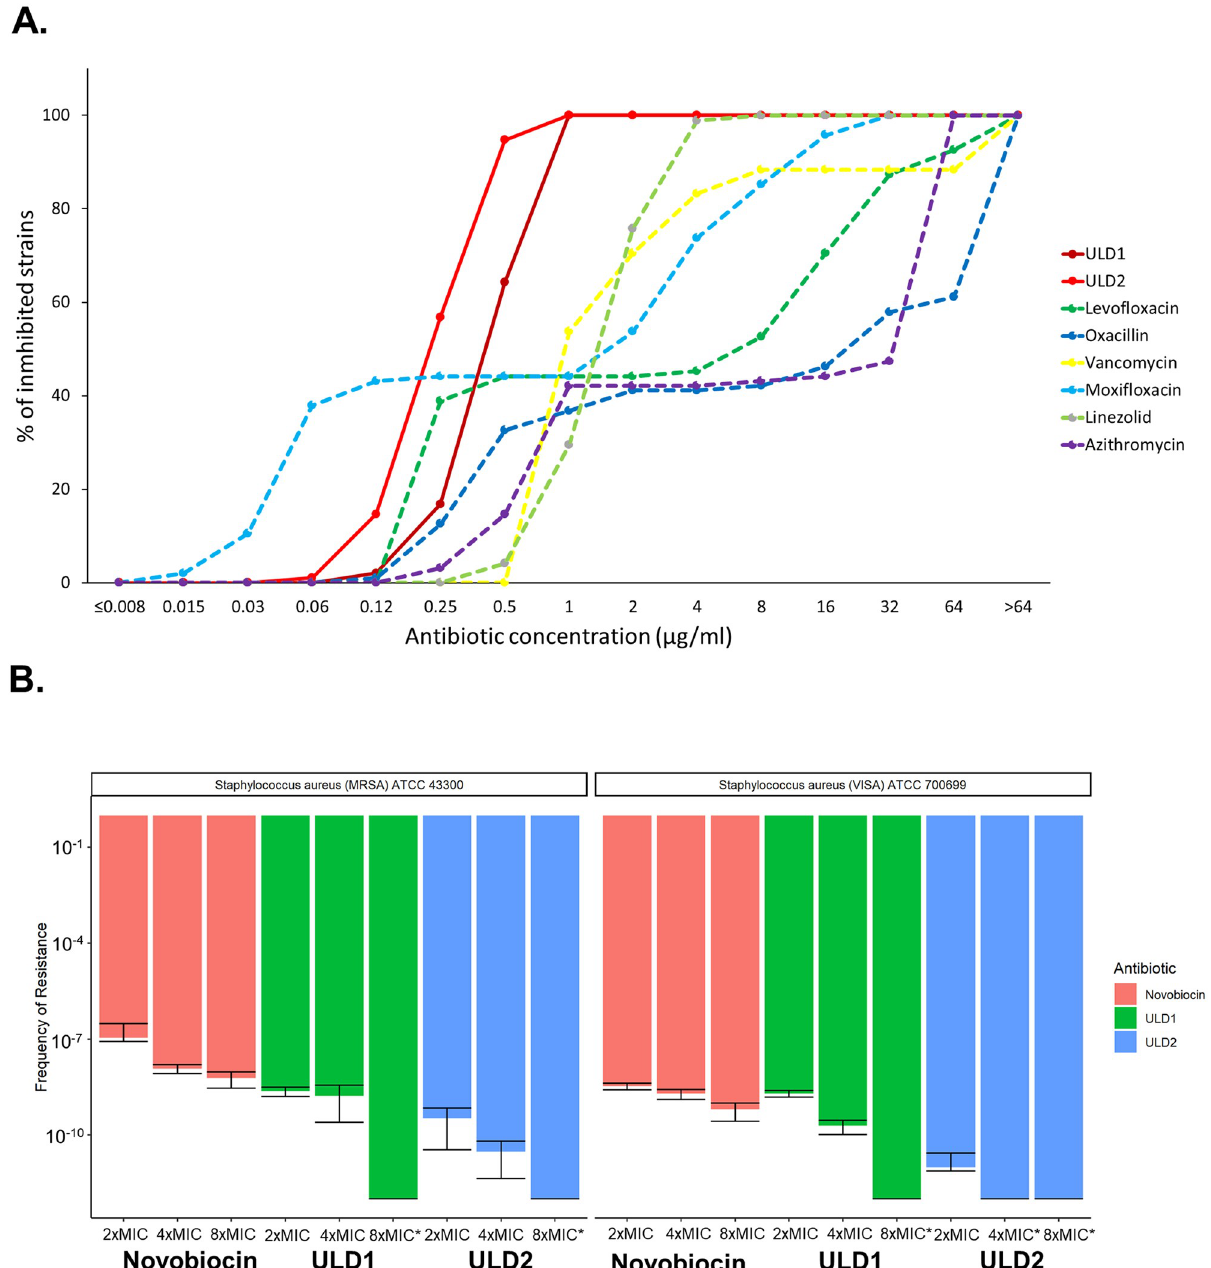
Fig 2. Antibacterial activities and spontaneous frequency-of-resistance of ULD1 and ULD2. A. Antibacterial activities of ULD1 and ULD2 against a panel of 95 S . aureus clinical isolates. Strains included 55 MRSA and 28 vancomycin-intermediate or -resistant isolates with diverse geographic origins (see S1 Data Table 1 for the strains’ description). All strains (100%) were inhibited at 1 μ g/mL concentration of ULD1 and ULD2. MICs were determined via broth microdilution according to CLSI guidelines. The underlying data for this figure can be found in S2 Data. B. Spontaneous frequency-of-resistance of ULD1, ULD2, and novobiocin in S . aureus MRSA ATCC 43300 (left panel) S . aureus VISA ATCC 700699 (right panel). Data are based on 10 independent biological replicates. Error bars indicate the 95% confidence interval. Asterisk ( � ) marks cases where the frequency-of- resistance was below 1 × 10 − 12 . The underlying data for this figure can be found in S2 Data. CLSI, Clinical and Laboratory Standards Institute; MIC, minimum inhibitory concentration; MRSA, methicillin-resistant S . aureus ; VISA, vancomycin-intermediate S . aureus .